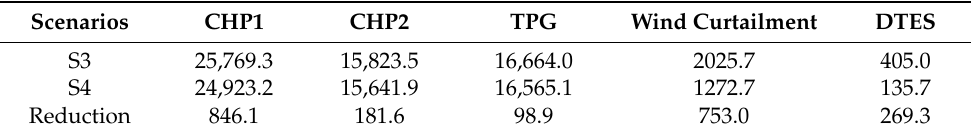
Table 3. Composition of annual operation and maintenance cost of scenarios S3–S4.